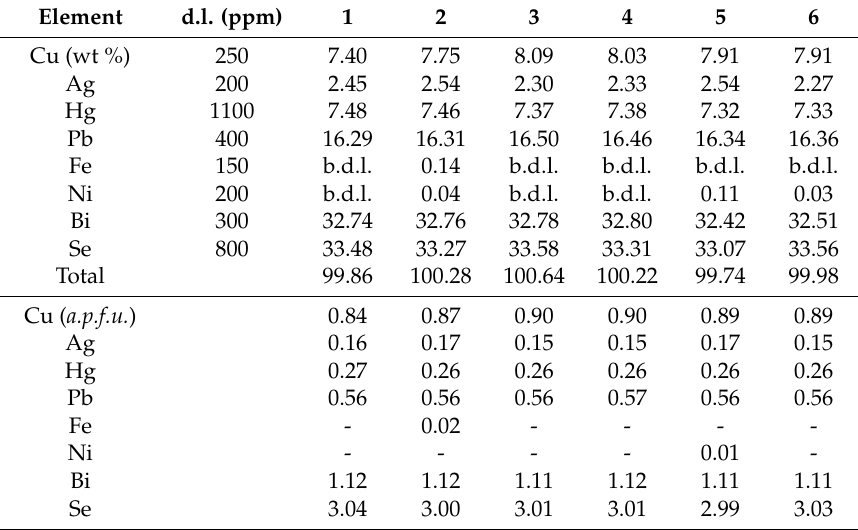
Table 3. Representative results of electron-microprobe spot analyses of cerromojonite.